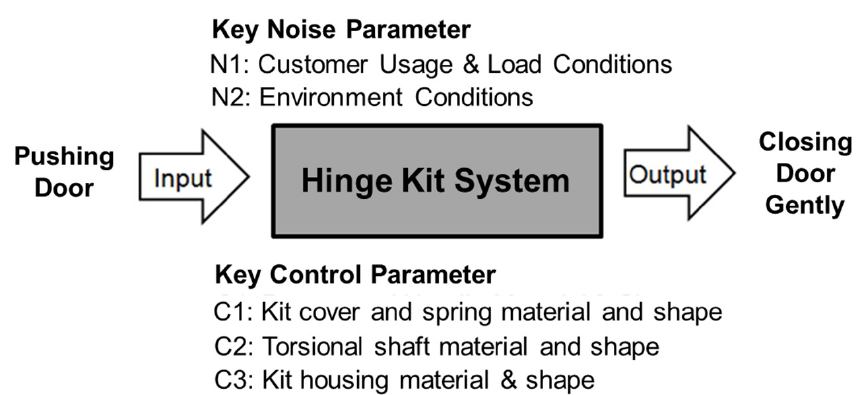
Figure 3. Parameter diagram of hinge kit system (HKS) (example).